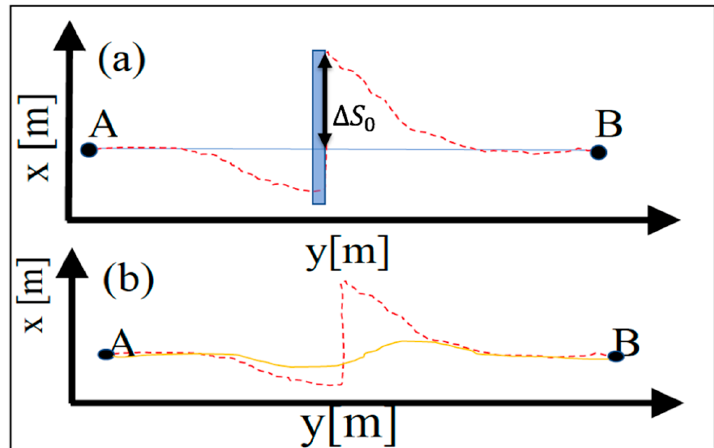
Figure 6. Definition sketch of shoreline evolution between points A and B for the cases of: ( a ) beach resistance owing to the groin (original shoreline: blue line; disturbed shoreline: red dashed line) and ( b ) beach resilience after the structure removal (perturbed shoreline: red-dashed line; shoreline position at time t i after structure removal: yellow line).